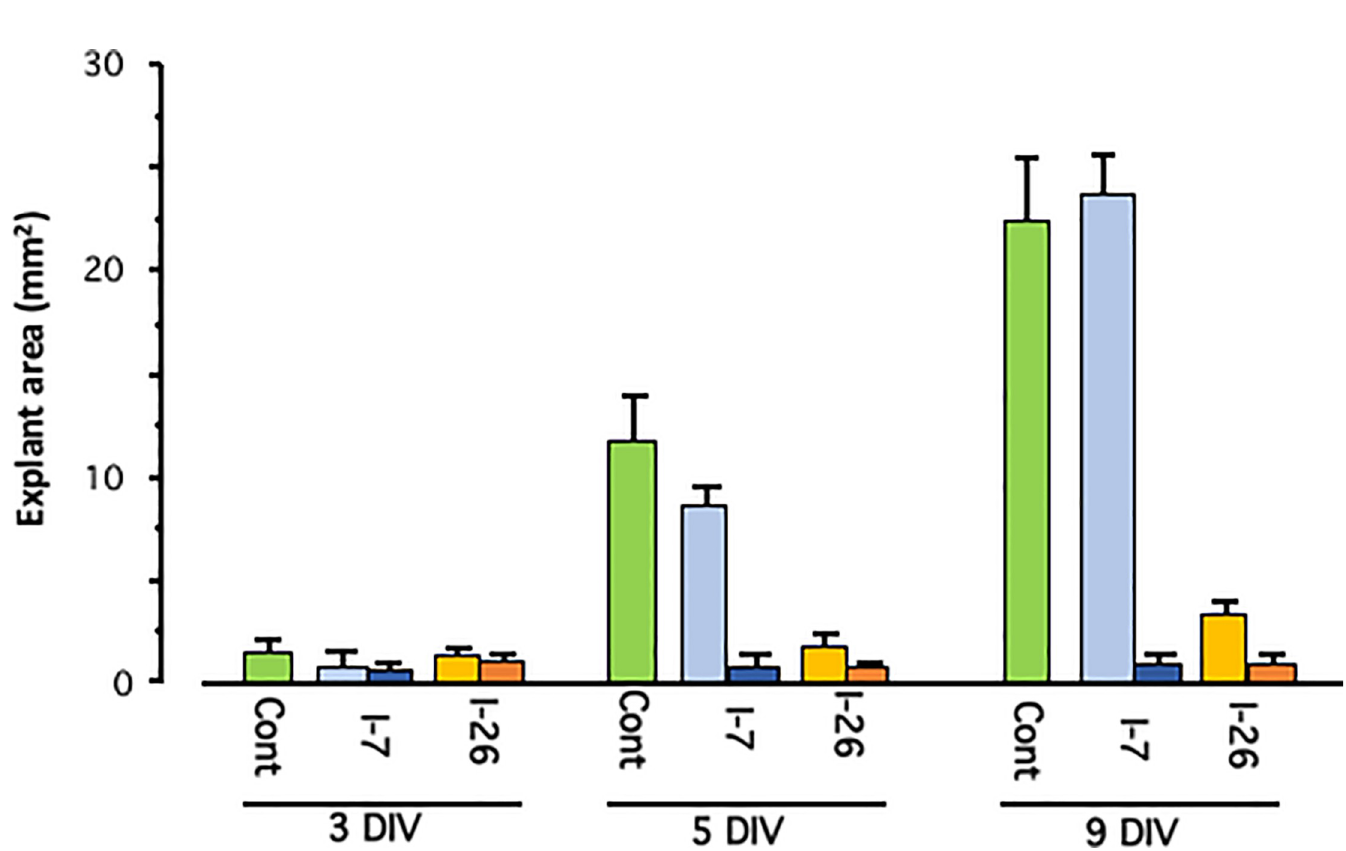
Fig 3. ME mucosal explant growth over time. Average explant areas after 3 DIV, the time at which inhibitors were added, and after 5 or 9 DIV. Negative control explants (green bars) showed steady growth over the culture period. Explants treated with 0.5 μ M of Library I compound 7 (light blue bars), an AKT inhibitor, did not show reduced growth. However, explants treated with 5.0 μ M (dark blue bars) failed to grow. Explants treated with Library I compound 26 at 0.5 μ M (light orange bars) or 5.0 μ M (dark orange bars) showed reduced growth compared to controls.